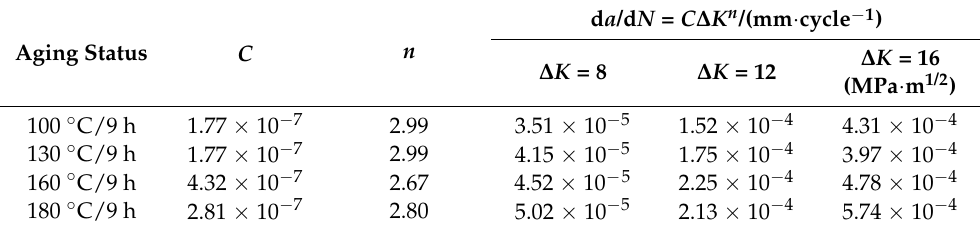
Table 2. Paris fitting parameters C and n at different creep-aging